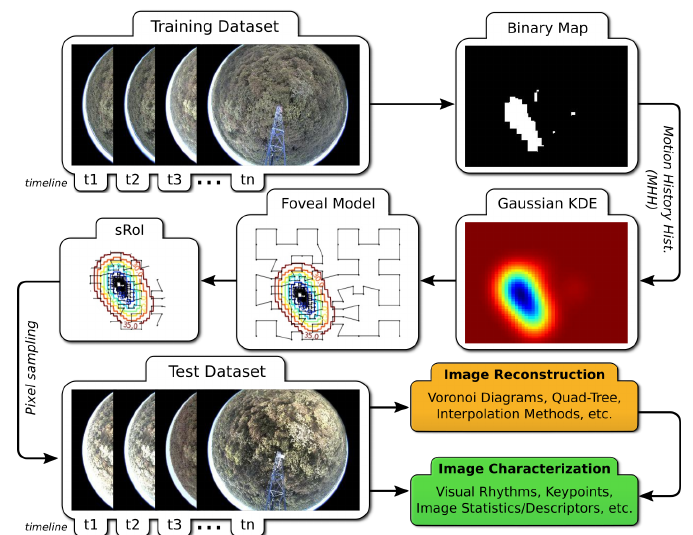
Figure 1. Proposed workflow to generate foveal models and resample phenological images.